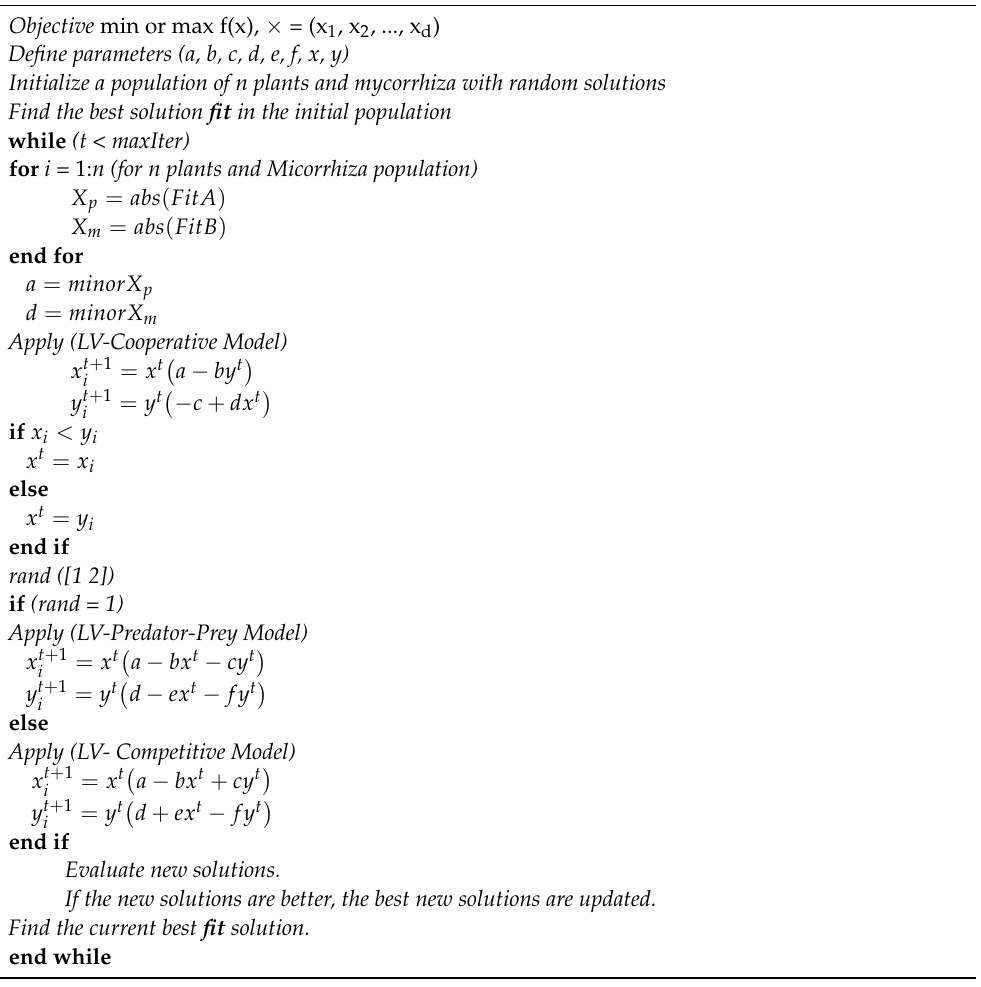
Algorithm 1. Discrete Mycorrhiza Optimization Algorithm